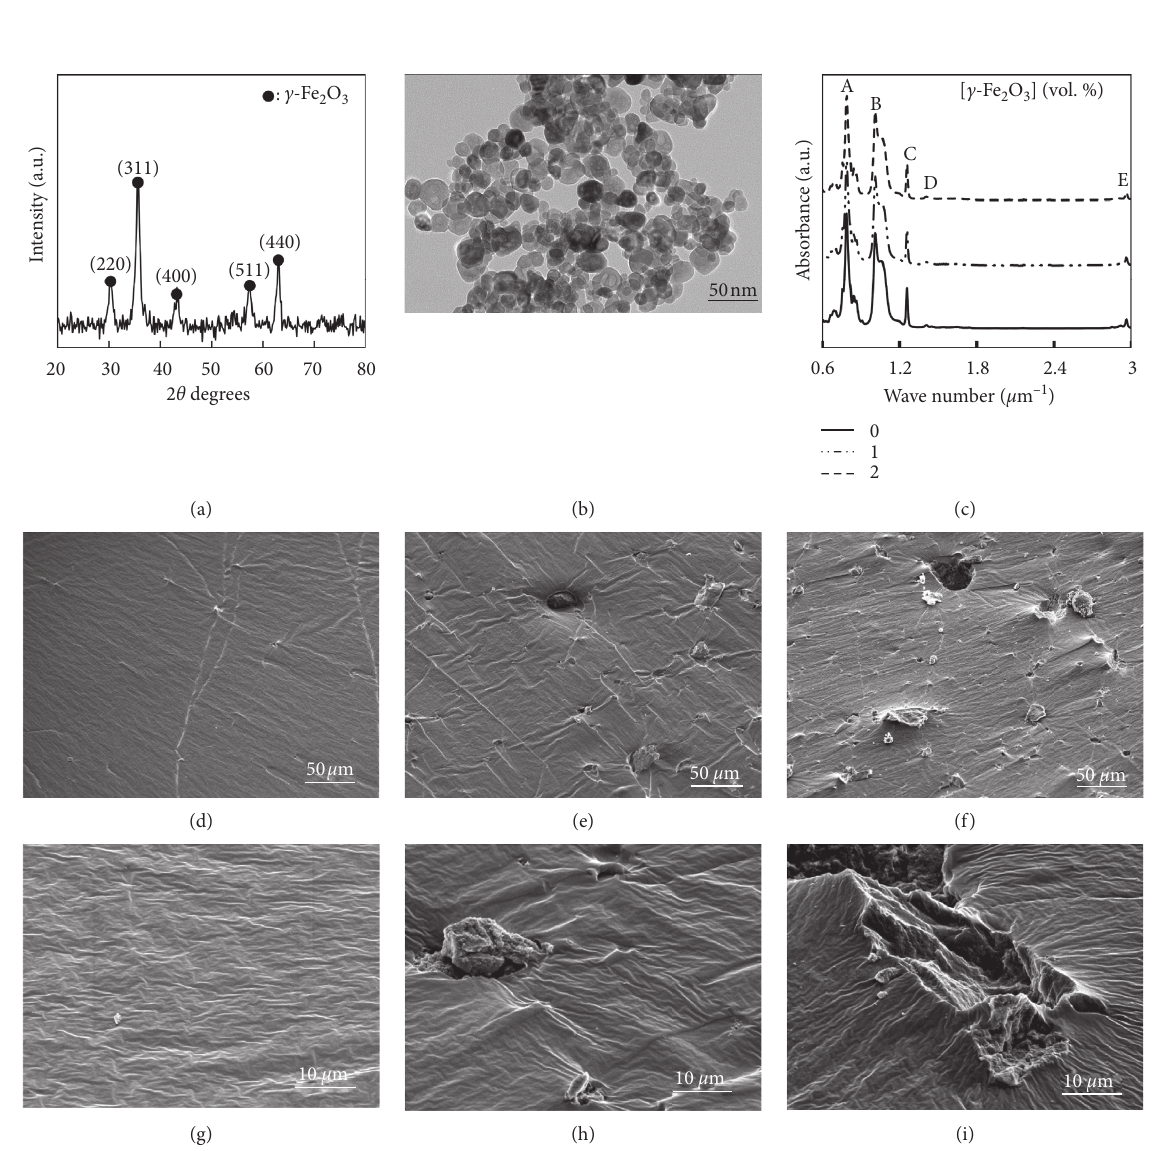
Figure 1: Structural characterization results. (a) X-ray diffraction spectra of c − Fe electron microscopy of c − Fe O at magnification of 0.5mm, scale bar: 50nm. (c) Fourier Transform Infrared of samples MNP-0, MNP-1, 2 3 MNP-2. Fractured surfaces of samples: (d) MNP-0, (e) MNP-1, and (f) MNP-2 at a magnification of 0.35kx and (g) MNP-0, (h) MNP-1, and (i) MNP-2 at a magnification of 2kx. Operating voltage �